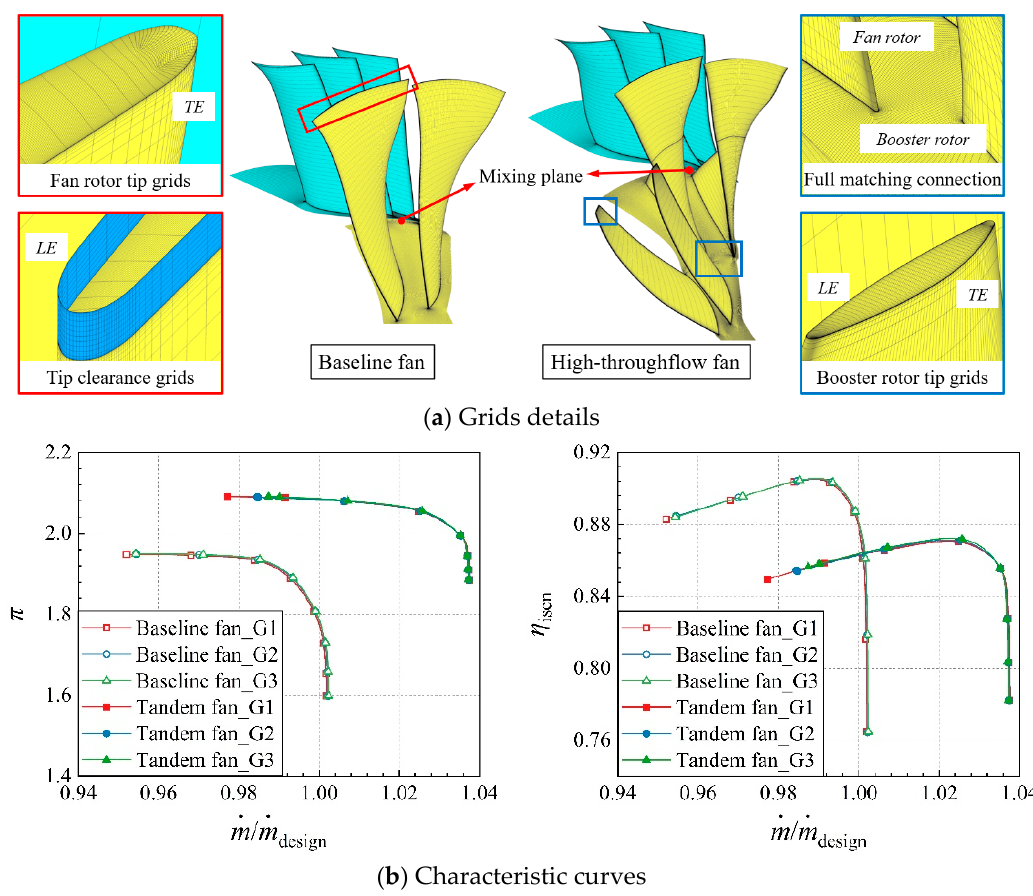
Figure 4. Grid independence study.